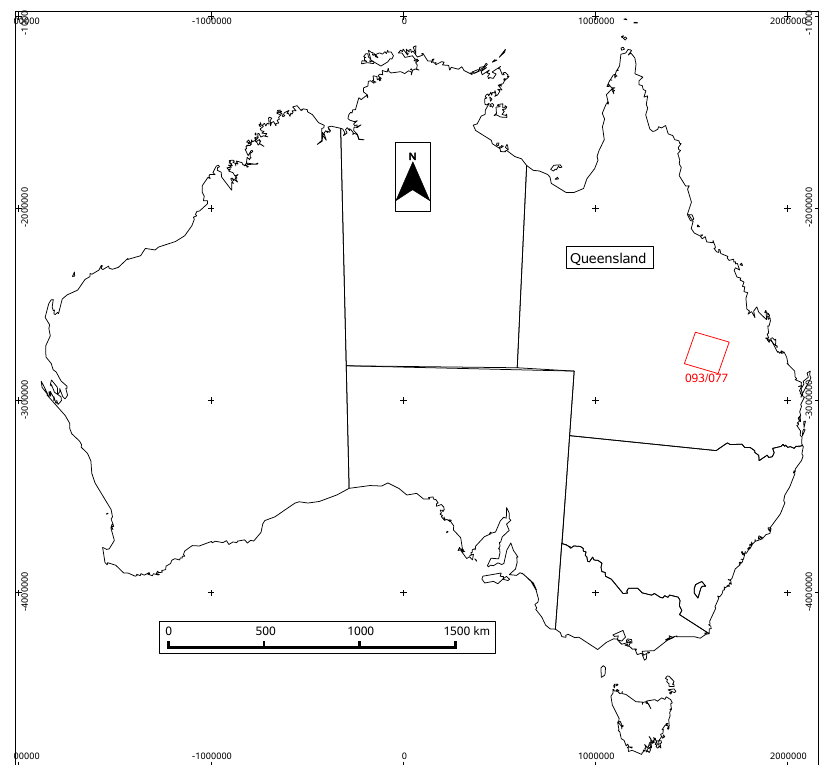
Figure 2. Australia, showing the state of Queensland, and the location of Landsat WRS-2 path/row 093/077 (in